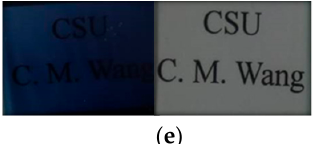
Figure 6. Transmittance spectra of ECDs: ( a ) WO 3 ; ( b ) LW1; ( c ) LW2; ( d ) LW3; ( e ) The photographs of the LW2 in coloring and bleaching state.